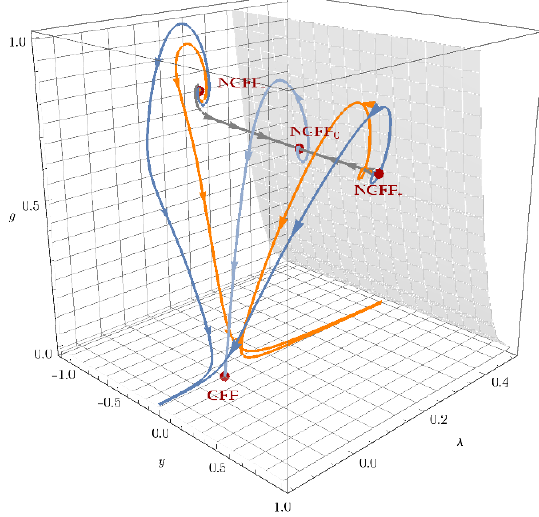
Figure 8 . Illustration of the phase diagram resulting from the beta functions (3.13) for N s = 1. Depicted are typical RG trajectories undergoing a crossover from the NGFP to the classical regime controlled by the GFP. Depending on whether the classical value of the cosmological constant found along the (cid:13)ow is positive (orange curves) or negative (blue curves) the trajectories are termed Type IIIa and Type Ia, respectively. The orange solutions terminate at (cid:17) sing displayed as the gray shaded N surface. All arrows point from UV to